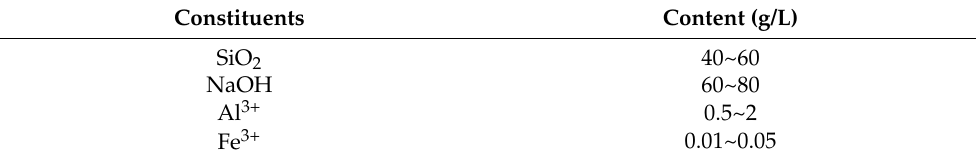
Table 2. Chemical composition of ESS.